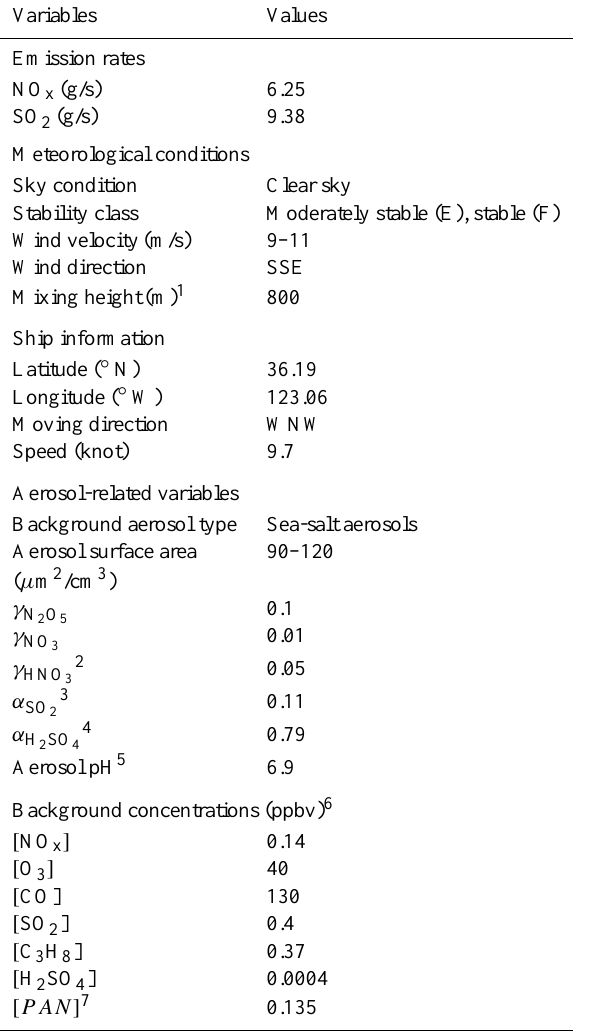
Table 2. Simulation conditions used in this study.